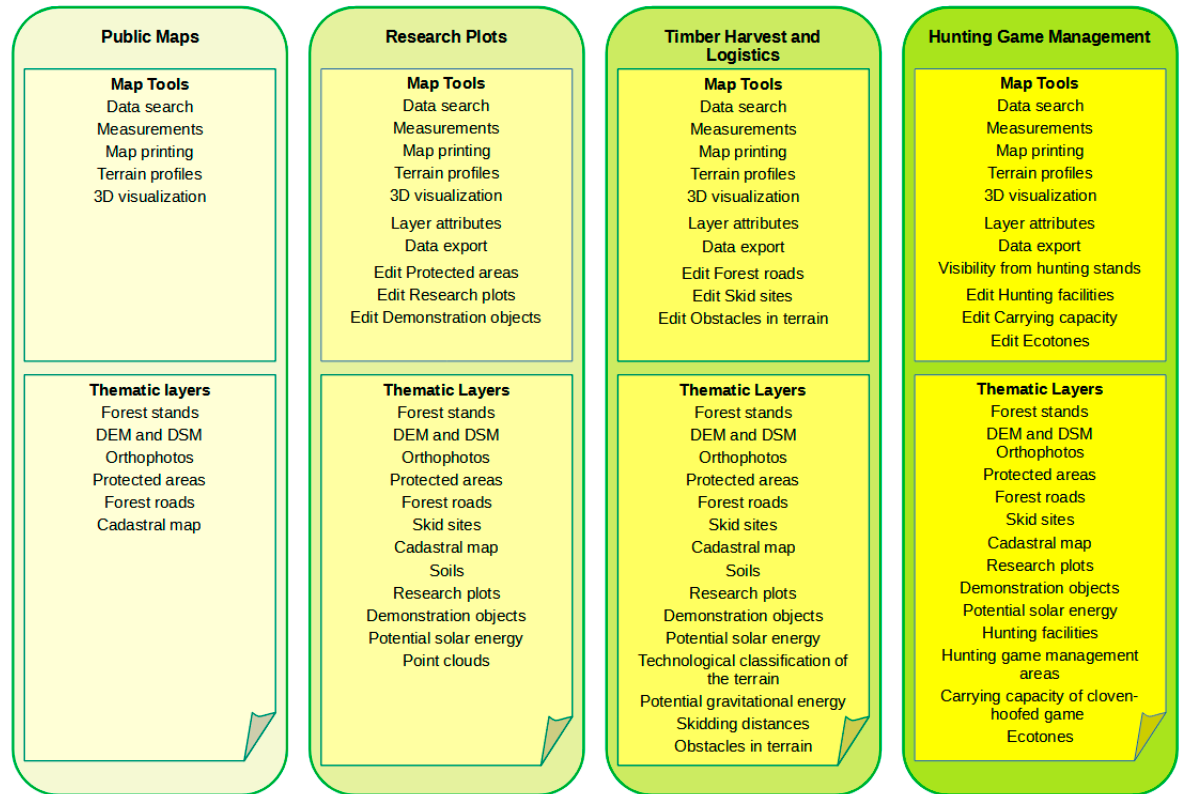
Figure 6. Schematic diagram of the web map applications.